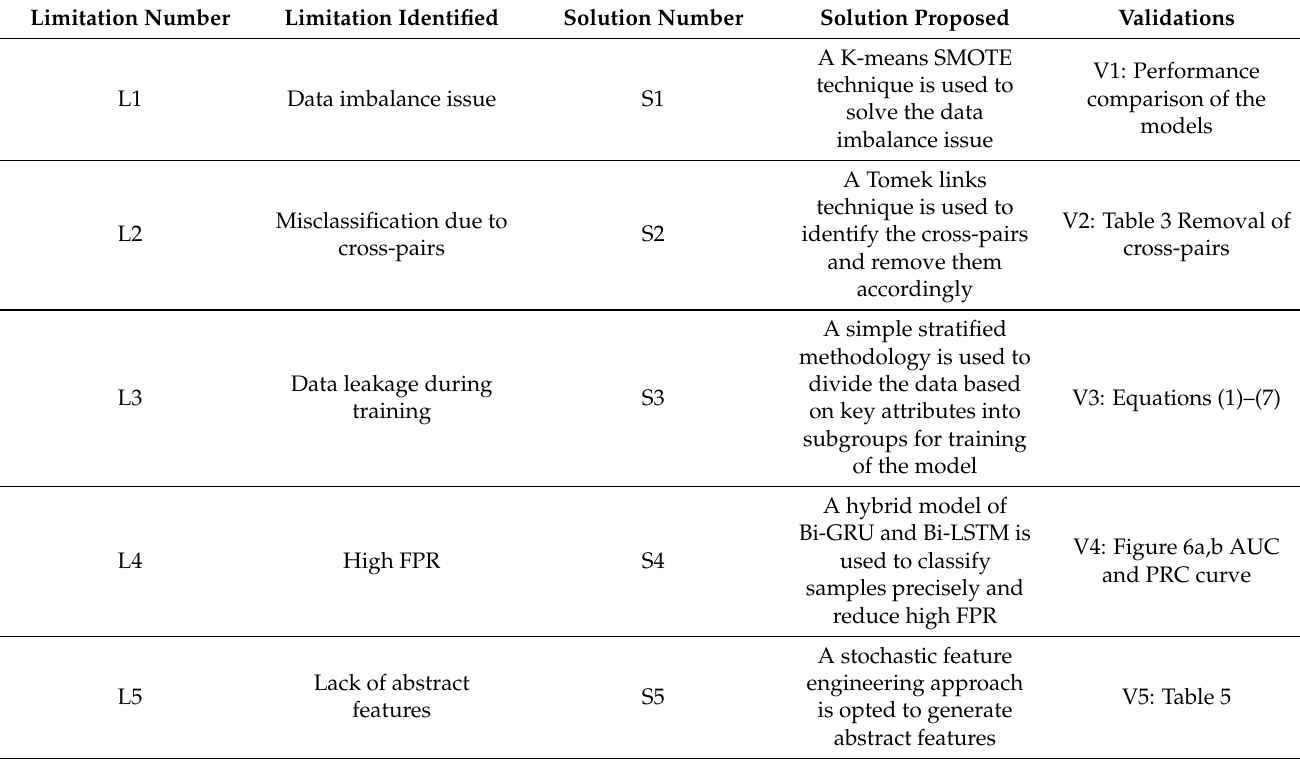
V4: Figure 6a,b AUC and PRC